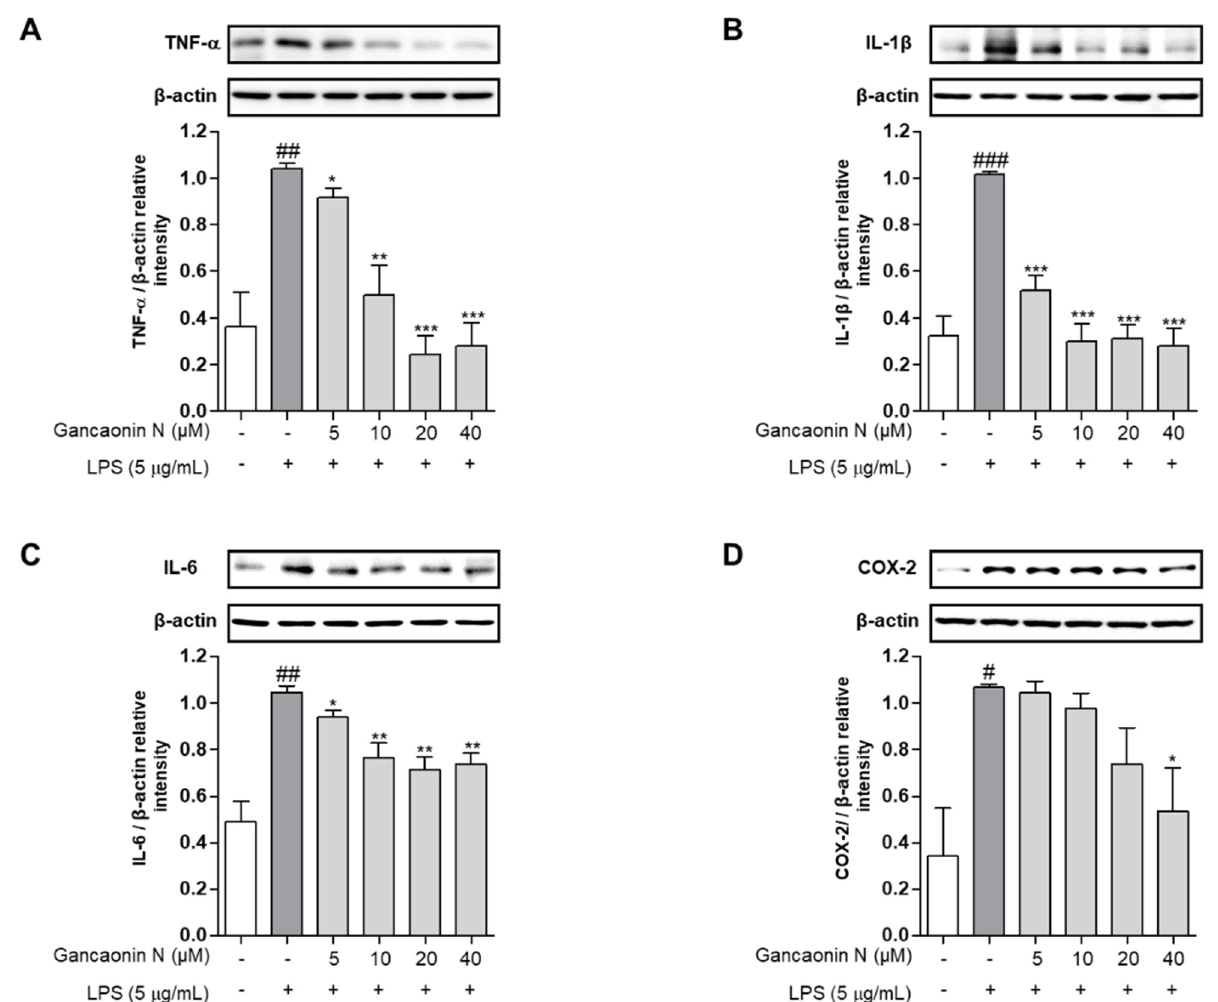
Figure 4. Effects of Gancaonin N on protein levels of pro-inflammatory cytokines ( A – C ) and COX-2 ( D ) in LPS-induced A549 cells. Gancaonin N (5–40 μ M) was pretreated 2 h prior to LPS-induced inflammation in A549 cells, incubated for 24 h with LPS (5 μ g/mL). The protein level of inflammatory biomarkers was investigated by immunoblotting assay. Ratio of each protein was determined by ImageJ. Values are represented as means ± SEM. # p < 0.05, ## p < 0.01, ### p < 0.001 are significantly different from non-treated group; * p < 0.05, ** p < 0.01, *** p < 0.001 are significantly different from only LPS- treated group.